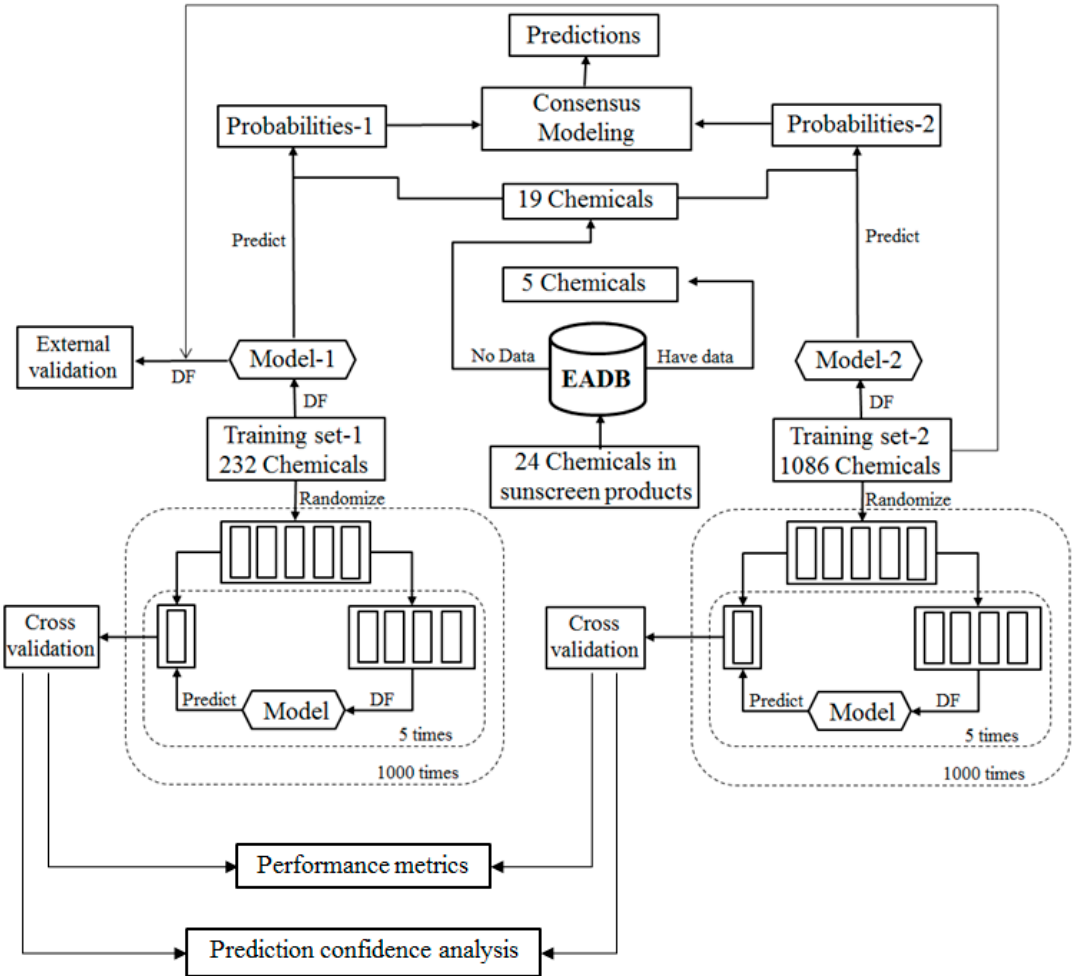
Figure 2. Workflow of the consensus classification modeling for classifying sunscreen ingredients as ER binders and non-binders.